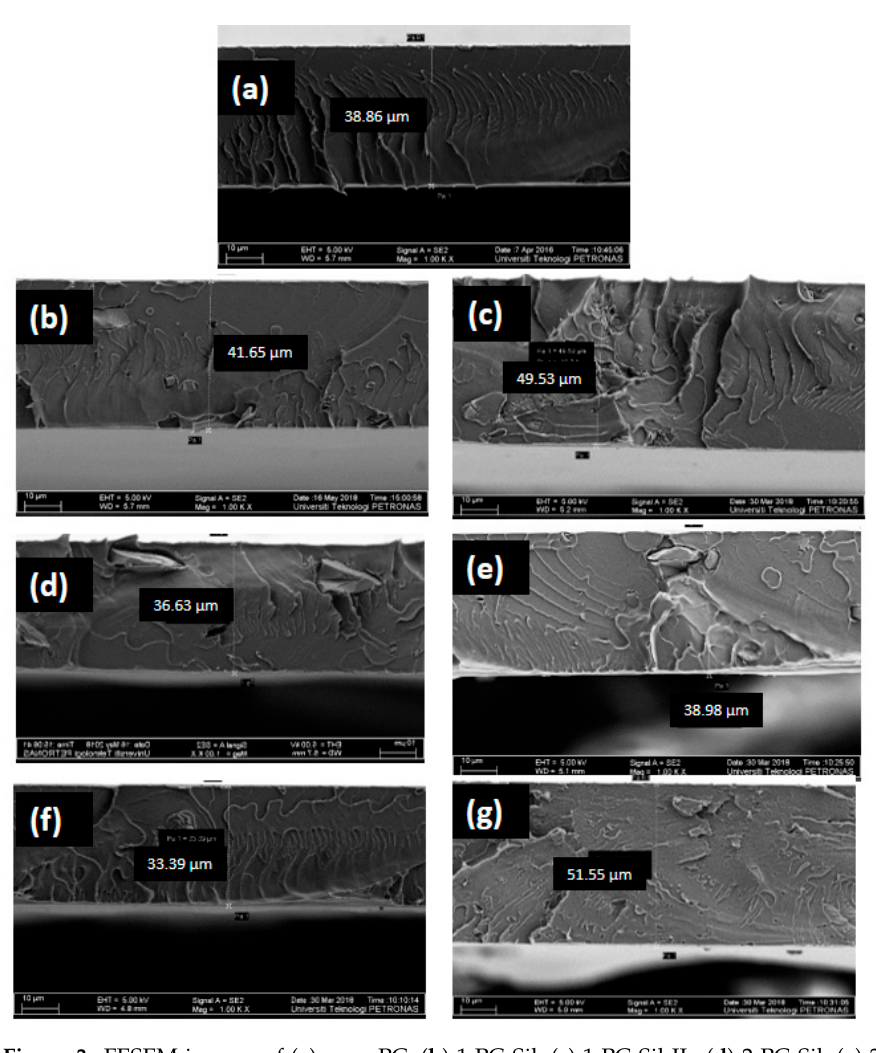
Figure 3. FESEM images of ( a ) pure PC, ( b ) 1 PC-Sil, ( c ) 1 PC-Sil-IL, ( d ) 2 PC-Sil, ( e ) 2 PC-Sil-IL, ( f ) 3 PC-Sil, ( g ) 3 PC-Sil-IL.